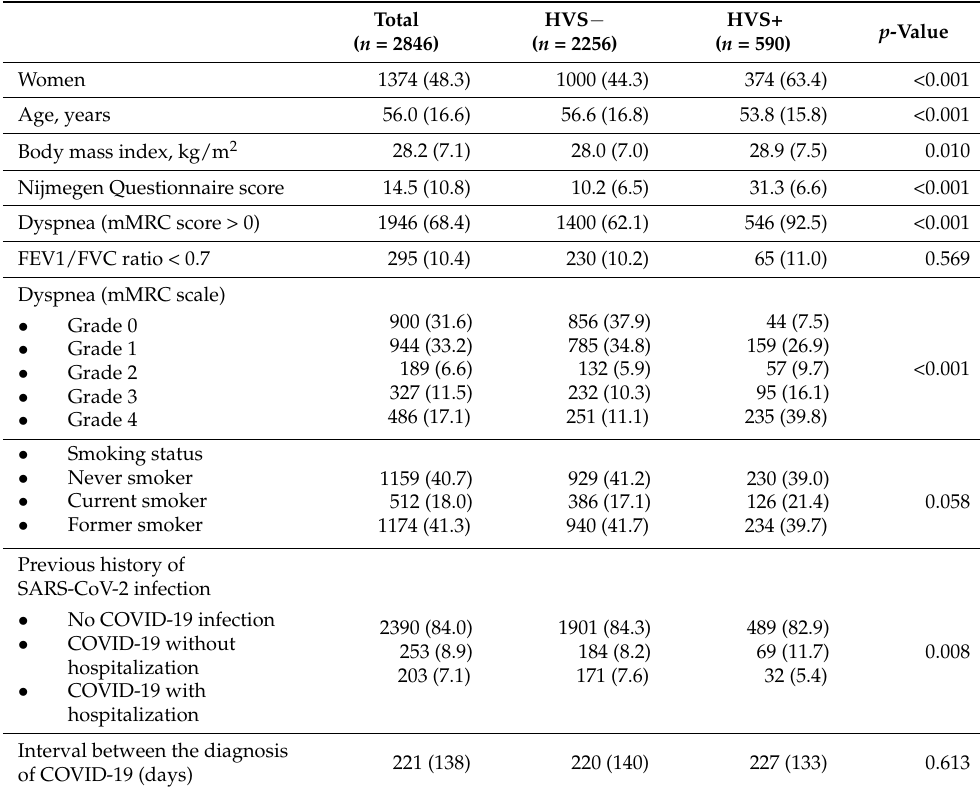
Table 1. Baseline demographic and clinical characteristics of included patients, according to HVS diagnosis ( n = 2846).